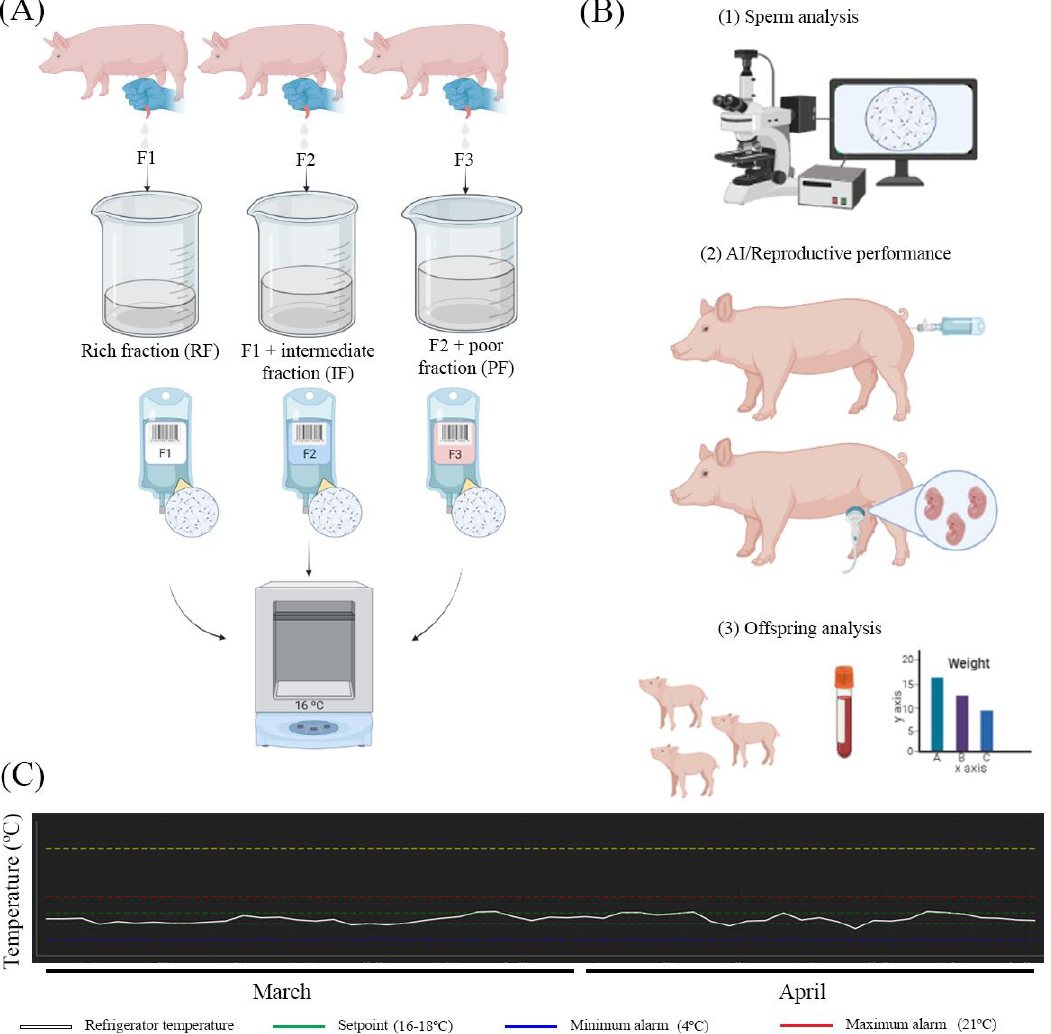
Figure 1. Scheme of the procedures carried out during the study. ( A ) The collection of the semen was performed according to the fractions of the ejaculate (F1 = rich fraction; F2 = F1 + intermediate fraction; F3 = F2 + poor fraction). The seminal doses were prepared for each type of ejaculate and kept at refrigeration until use. ( B ) On day 3 of conservation, the seminal doses were used for controlling the semen quality and for AI. The inseminated sows were diagnosed in pregnancy by ultrasound, and offspring was evaluated (growth and blood analysis). ( C ) Seminal doses were conserved in a temperature-controlled refrigerator during the whole period of the trial (March and April 2021).